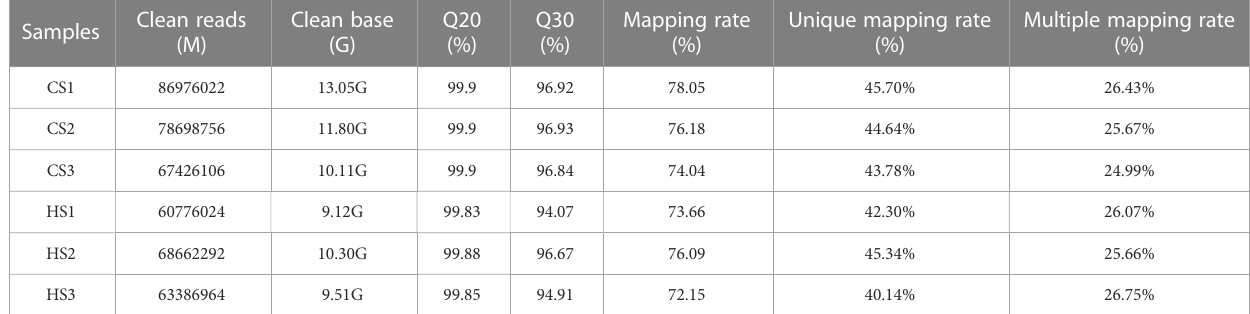
TABLE 1 Statistical data for RNA-seq.